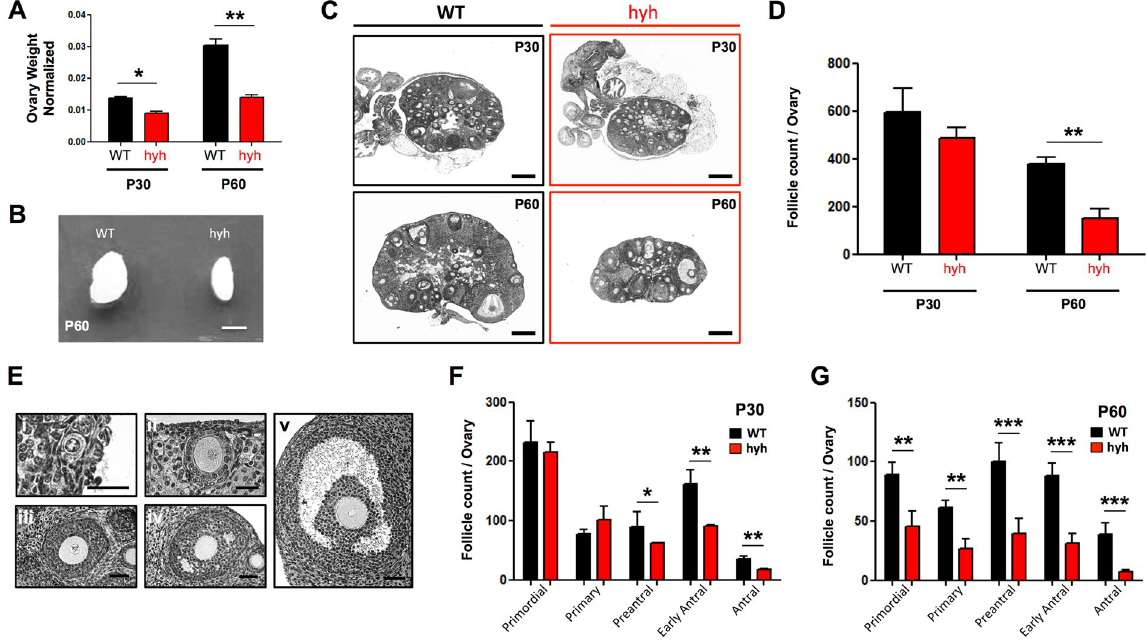
Figure 3. Ovarian phenotype and ovulation capacity of α -SNAP mutant (hyh) females. ( A ) Ovary relative to body weight in WT (black bars) and hyh mutant (red bars) P30 and P60 females. ( B ) Representative image of P60 WT and hyh ovaries. Scale bar, 2mm. ( C ) Representative histological sections of WT and hyh mutant ovaries at P30 and P60. Scale bars, 200 μ m. ( D ) Number of follicles per ovary in P30 and P60 WT and hyh females. ( E ) Representative images of ovarian follicles at different developmental stages: primordial (i), primary (ii), preantral (iii), early antral (iv), and antral (v) follicles. Scale bars, 25 μ m (i–ii) and 50 μ m (iii–v). ( F , G ) The number of follicles in each stage per ovary was analyzed in P30 ( F ) and P60 ( G ) WT and mutant hyh ovarian histological serial sections. Bars represent mean ± SEM of 4 independent experiments. * p < 0.05; ** p < 0.01; *** p < 0.001 (Student’s